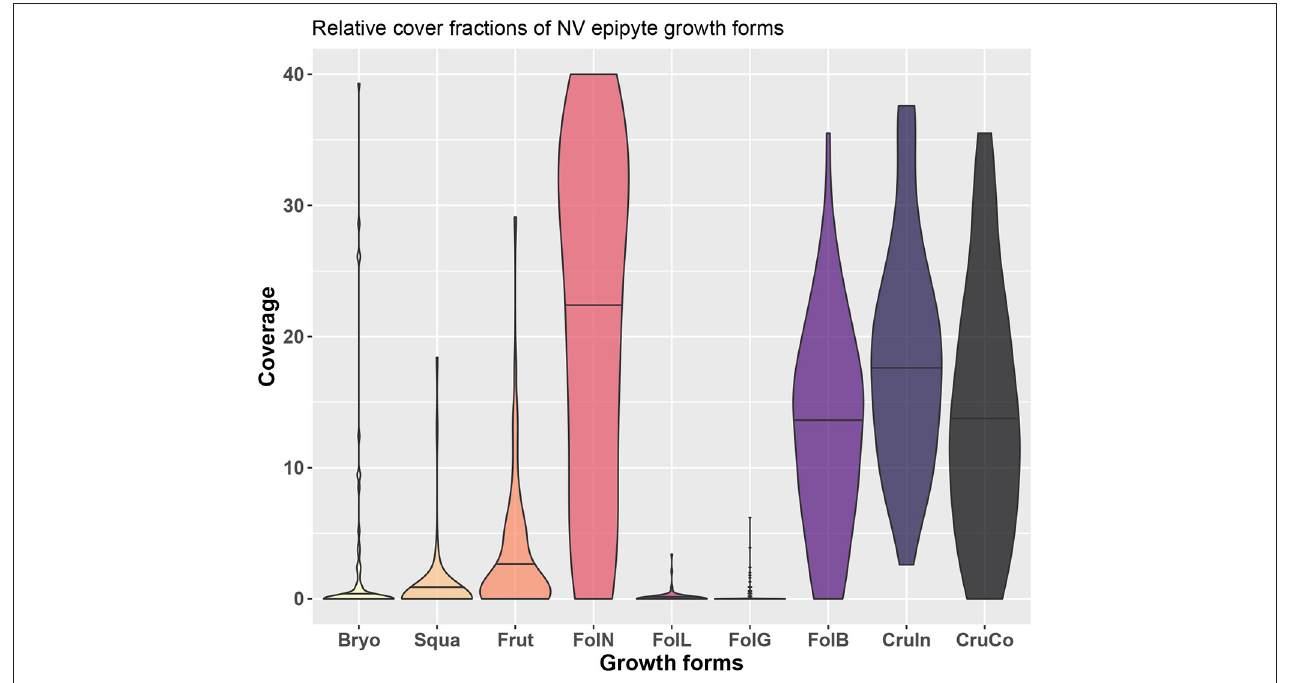
FIGURE 4 | Overview of growth forms at the study site and the distribution of their relative cover across different trees.